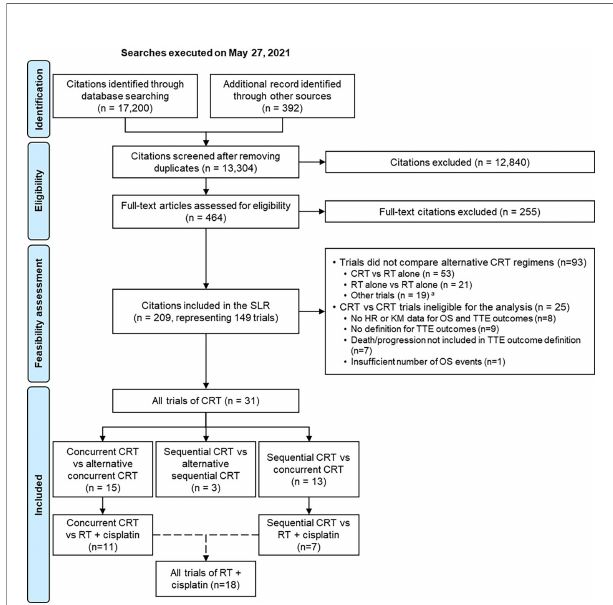
FIGURE 1 | PRISMA fl ow diagram for the systematic literature review and the meta-analyses. CRT was de fi ned as the combination of RT and any class of systemic therapies, including chemotherapy, targeted therapy or a combination of both. a Trials comparing different doses/ schedules of the same CRT regimen; to one another. HR, hazard ratio; KM, Kaplan-Meier; OS, overall survival; PRISMA, Preferred Reporting Items for Systematic Reviews; RT, radiotherapy; SLR, systematic literature review; TTE,